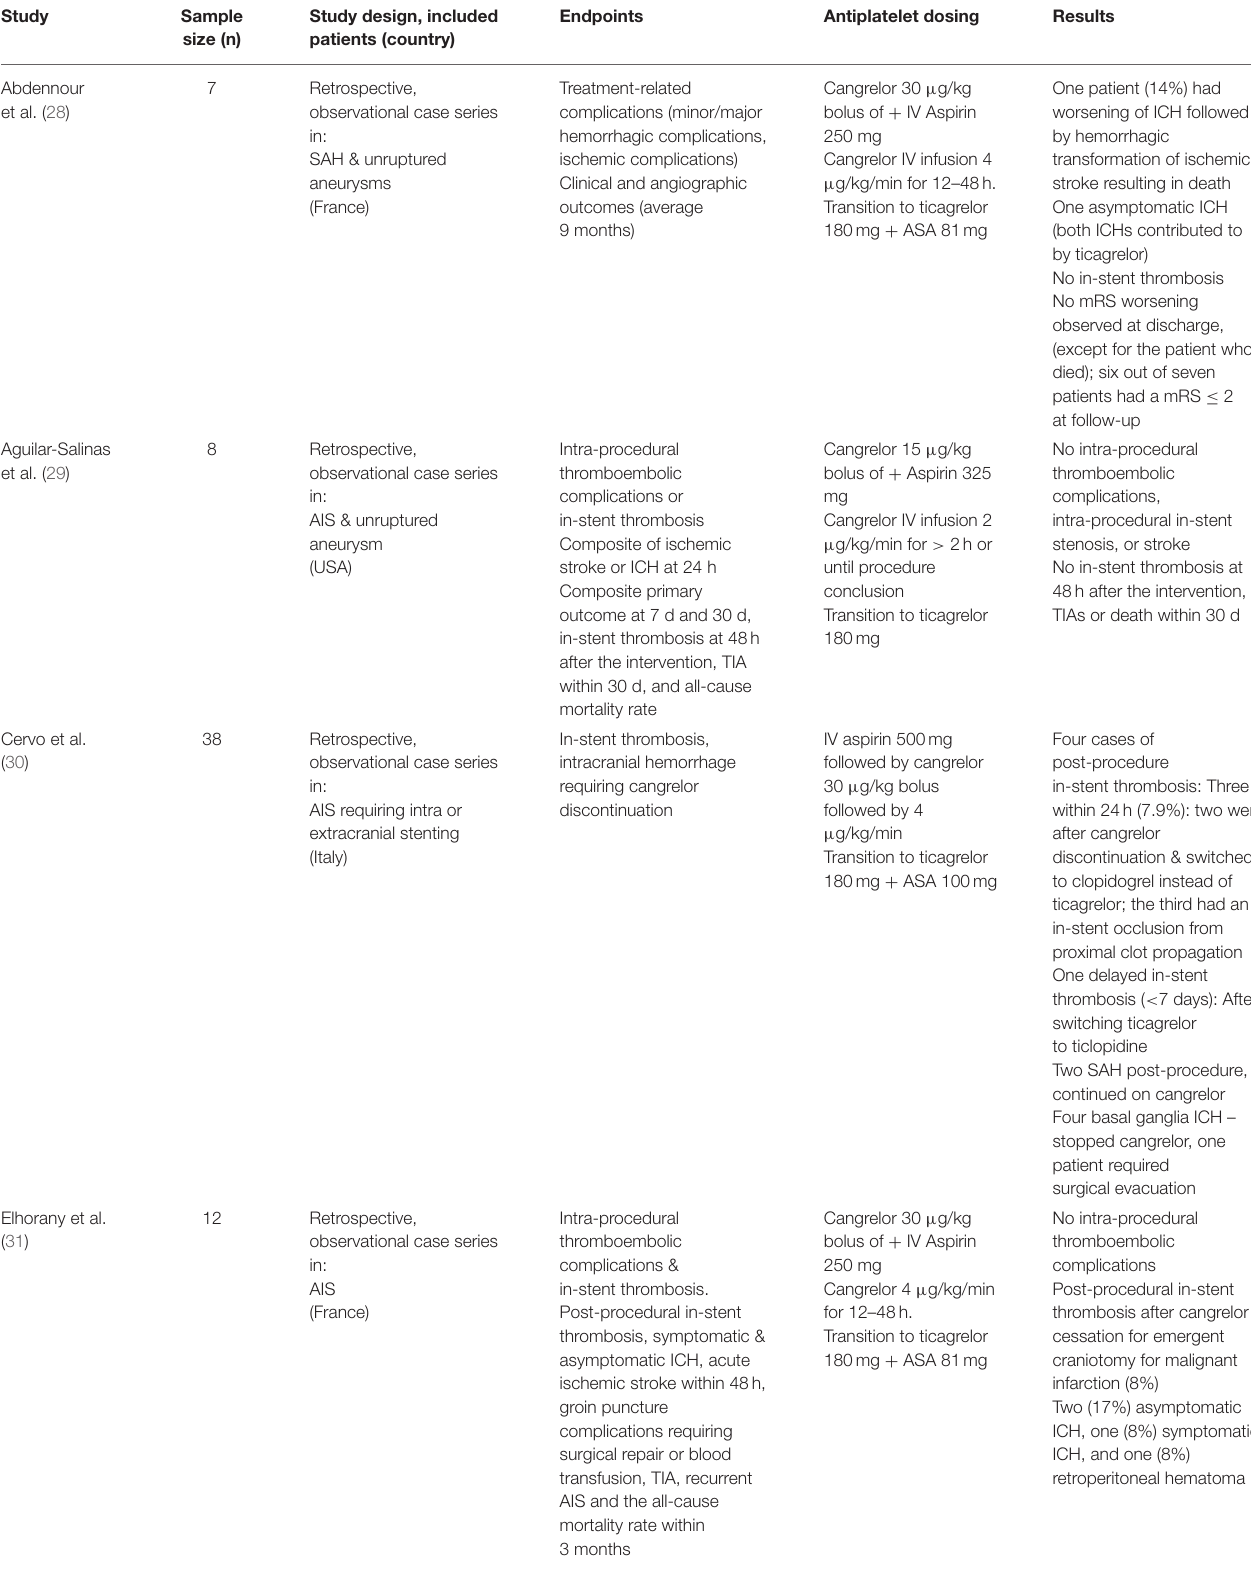
TABLE 4 | Summary of recently published studies evaluating intravenous cangrelor for cerebrovascular diseases.